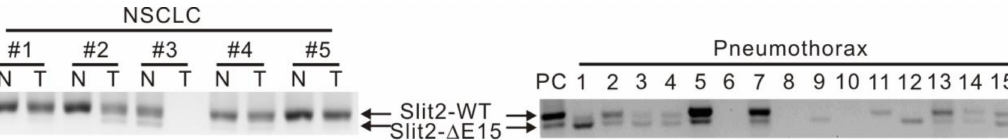
Figure 1. Expressions of Slit2-exon15 isoforms in lung cancer and pneumothorax specimens. Left panel shows the Slit2-exon15 isoforms expressed in the NSCLC (non-small cell lung cancer) specimens. Slit2 is highly repressed in lung tumors. To observe the isoforms in the tumors, the product of two to three PCRs (25 µ L/reaction) was precipitated and loaded onto the gel, whereas only 5 µ L of PCR was loaded for the normal lung counterparts. Slit2-WT is the predominant form expressed in both normal lungs and lung tumors. Right panel shows the expression pattern of the Slit2-exon15 isoforms in the pneumothorax patients. The expression pattern of the Slit2-exon15 isoforms varies among the specimens. Table 1. Expression of Slit2-exon15 isoforms in lung cancer and pneumothorax patients. Diseases p a Slit2 Splicing Variants n Lung Cancer